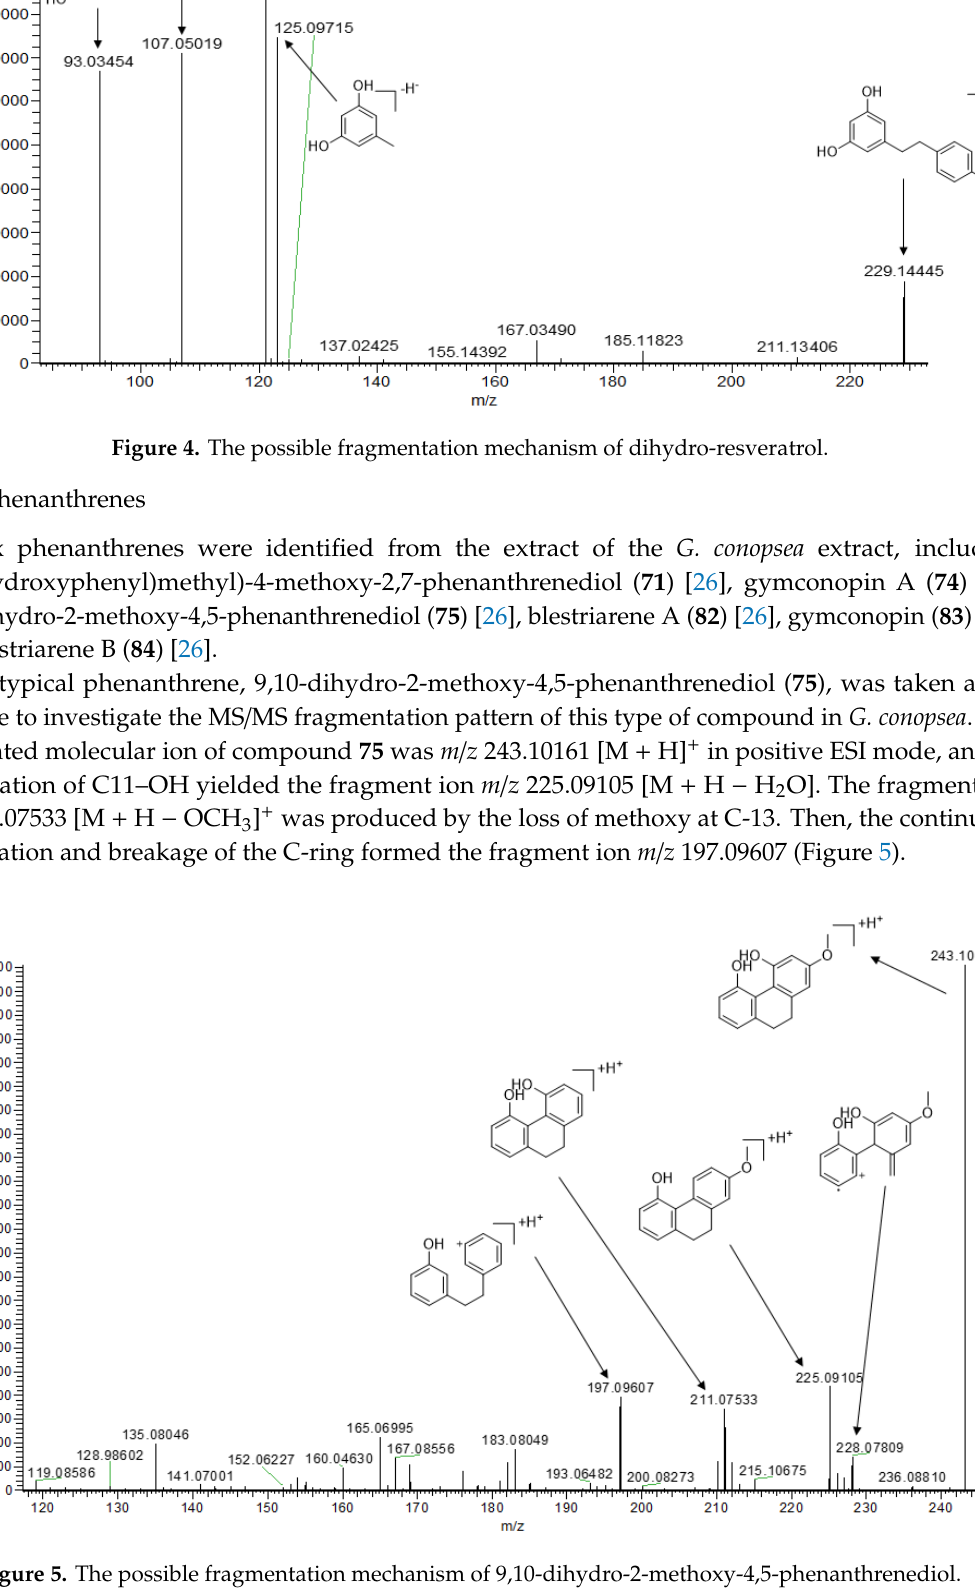
Figure 5. The possible fragmentation mechanism of 9,10-dihydro-2-methoxy-4,5-phenanthrenediol.